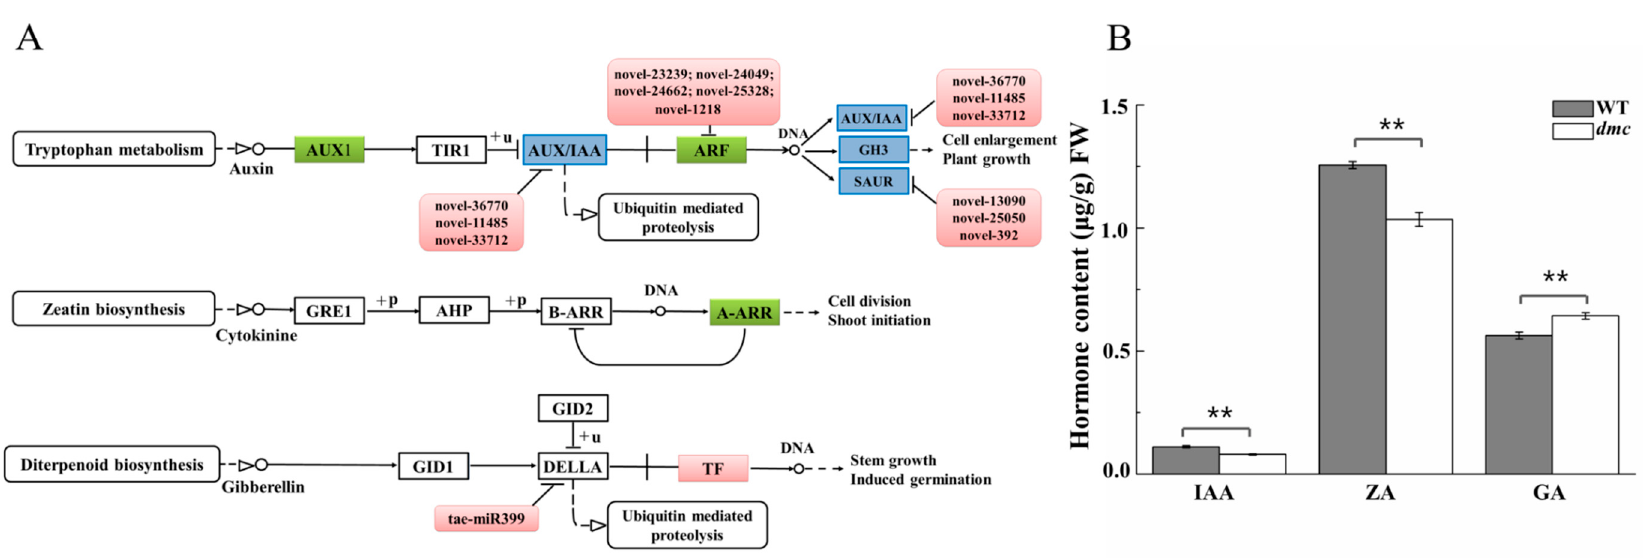
Figure 8. The auxin (IAA), zeatin (ZA) and gibberellin (GA) contents and the metabolism pathways. ( A )The phytohormone metabolism pathways referenced to ko04075 in the KEGG database. ( B ) The contents of IAA, ZA, and GA in tiller nodes of dmc and WT. Pink: highly expressed in dmc ; green: lowly expressed in dmc ; blue: no difference in expression between dmc and WT.